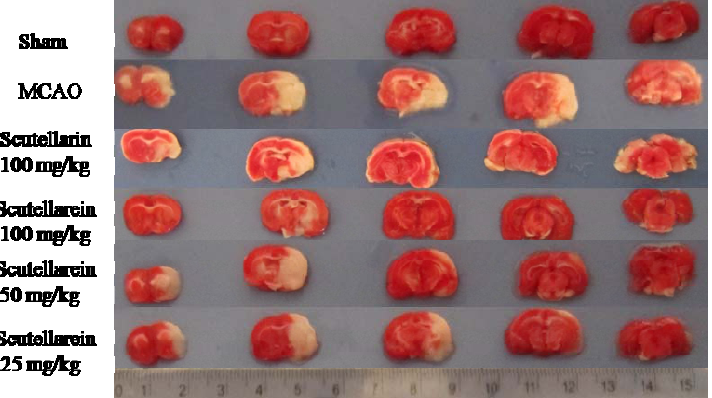
Figure 1. The effect of scutellarein on cerebral infarction volume by TTC